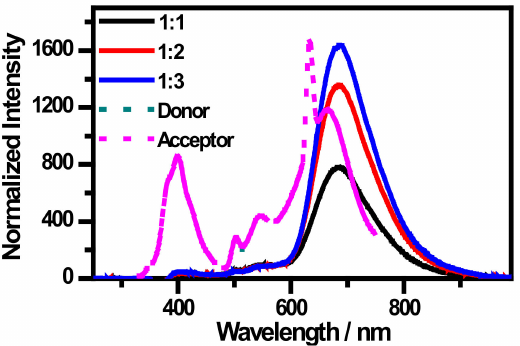
Figure 8. Emission spectra of G1PPT-co-P3HT, PDI-co-Carbazole and their blends [1].